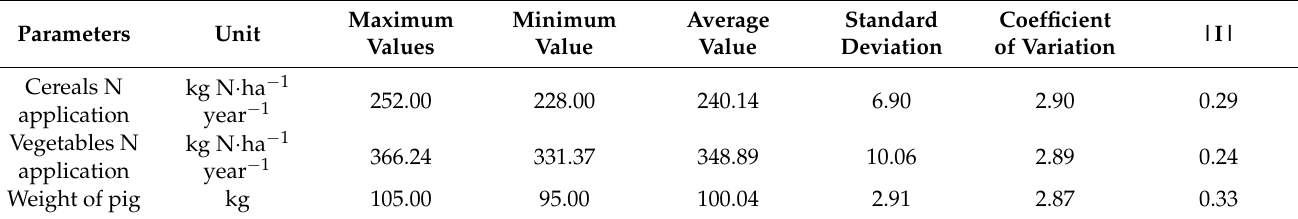
Table 1. Results of the parameter sensitivity and uncertainty